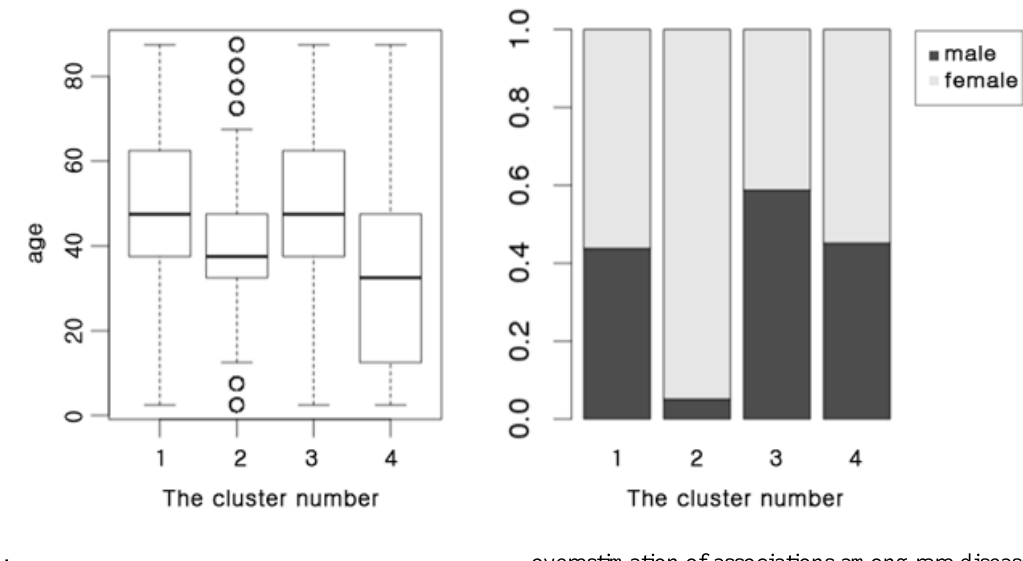
Figure 7. Age distribution and sex ratio for the four major